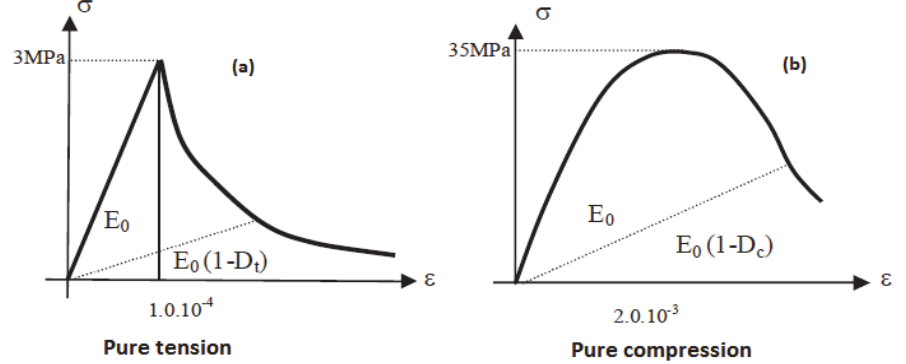
Figure 2: Uniaxial response of the model in (a) tension and (b) compression [5]